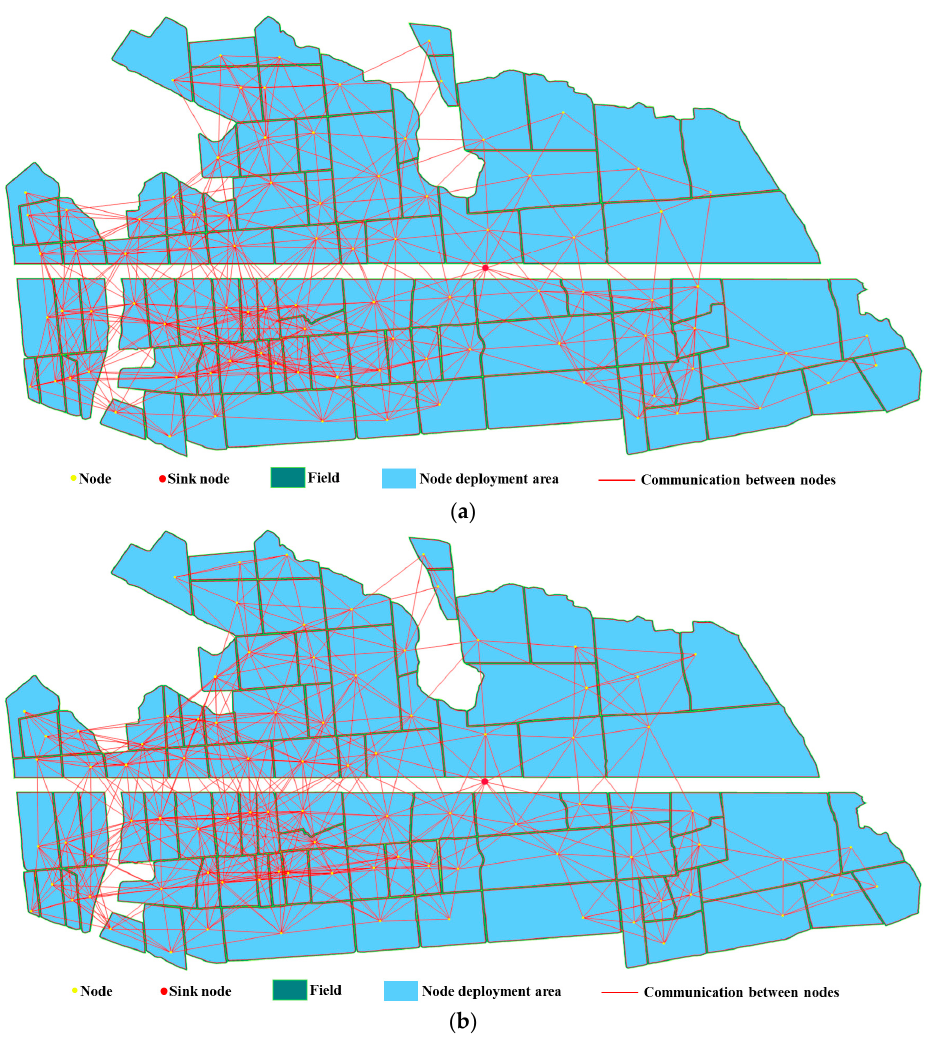
Figure 16. The WSN deployment on natural farmland located in Nanjing, Jiangsu Province, China. The communication distance is 200 m. ( a ) k = 3; ( b ) k = 4.